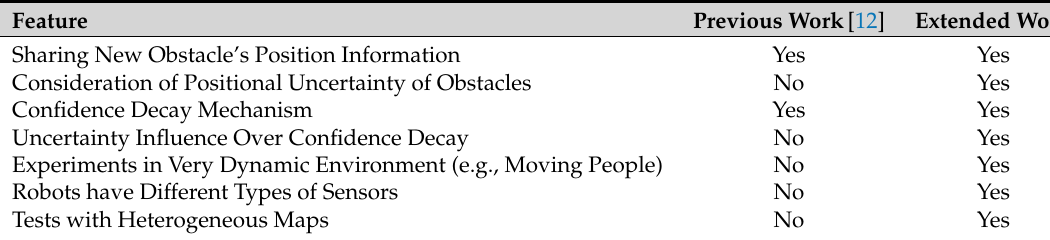
Table 1. Comparison of this extended work with the previous work